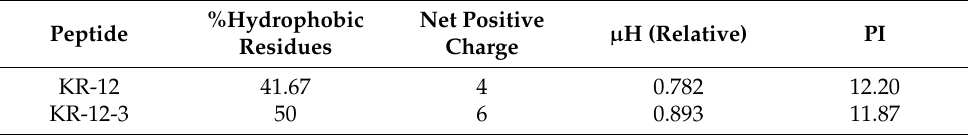
Table 2. Structural parameters of KR-12 and KR-12-3. The hydrophobic residue composition (% hydrophobic residues), net positive charge, and relative amphipaticity ( µ H relative) for each peptide were